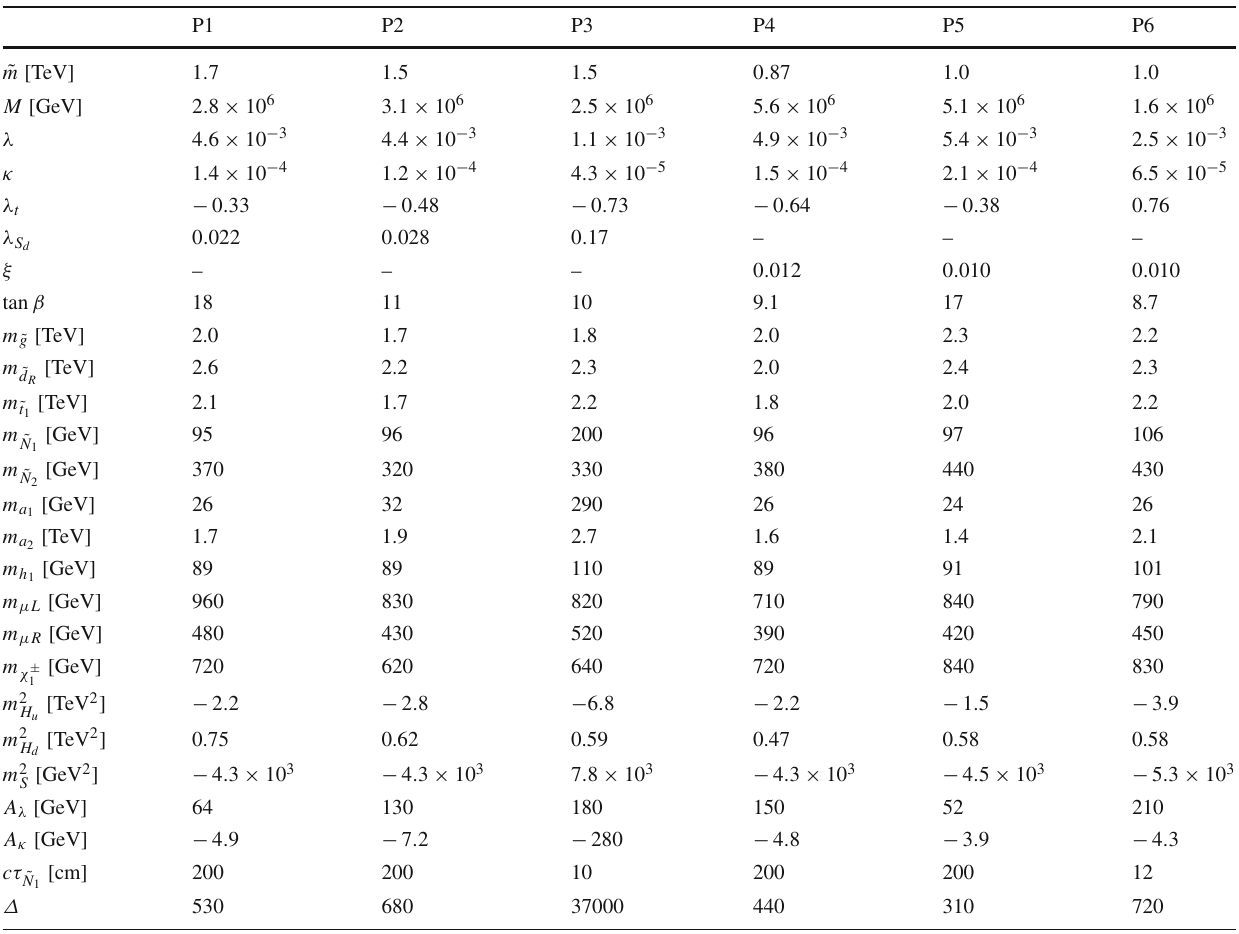
Table 1 Benchmarks consistent with all experimental constraints, including LHC direct search limits. P1–P3 are points in the U model, while P4–P6 belong to the DGSU model. All points have reduced SM- like Higgs signal strengths of about 0.84, corresponding to a Higgs-